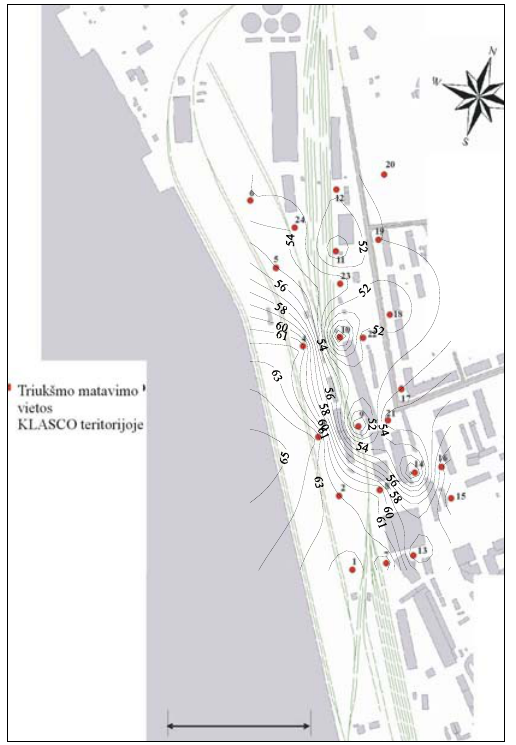
Fig 13. Dispersion of reciprocal noise level in the evening in